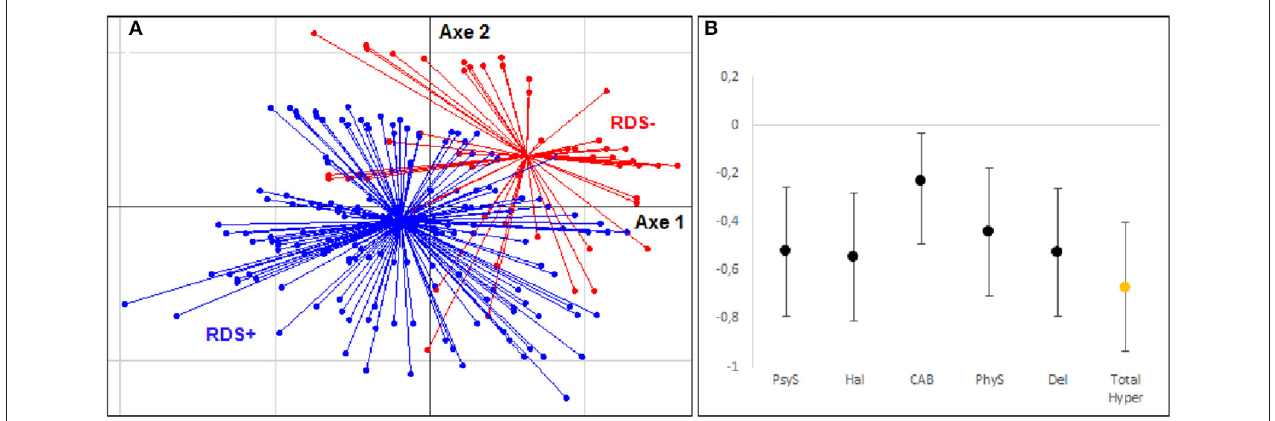
FIGURE 1 | Multidimensional factor analysis and effect size for hyperdopaminergic components. (A) Tridimensional representation of the distribution of subjects with and without depressive symptoms during cocaine withdrawal (RDS– group in Red, RDS + group in Blue) according to clinical variables of hyperdopaminergia: psychotic symptoms (PsyS), hallucinations (Hal), delusions (Del), consumption-associated behavior (CAB), physical symptoms before use (PhyS). (B) Hedges’ effect-size of each variable for the hyperdopaminergic components.